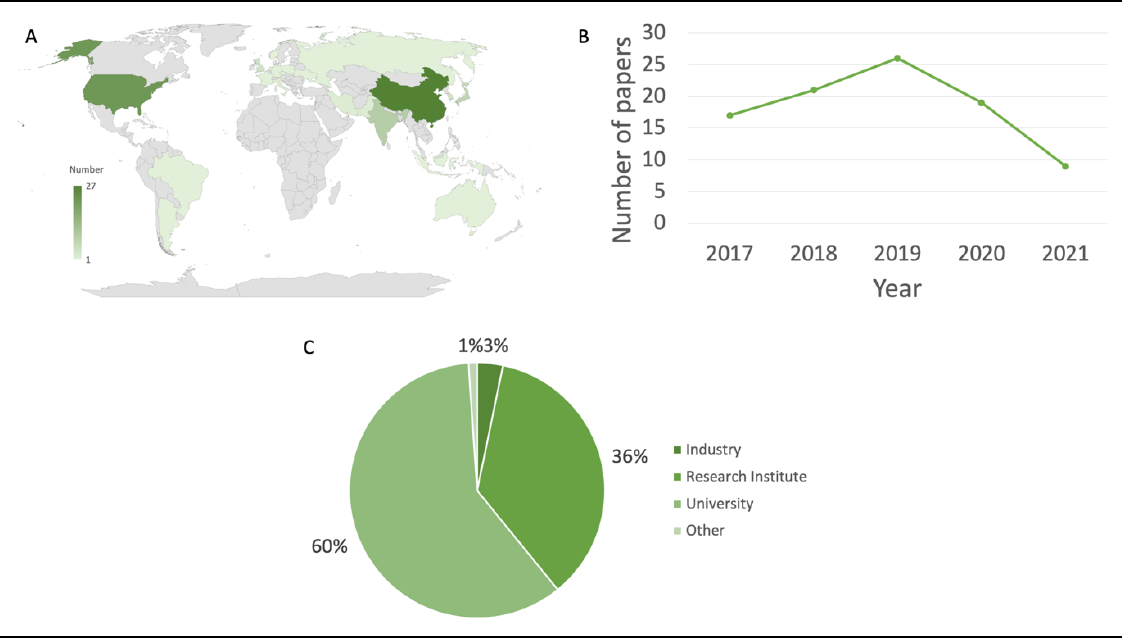
Figure 2. Study metrics included in the literature review. ( A ) Number of articles per country. Legend range from – 127 articles. ( B ) Number of studies per year. ( C ) Author affiliation.